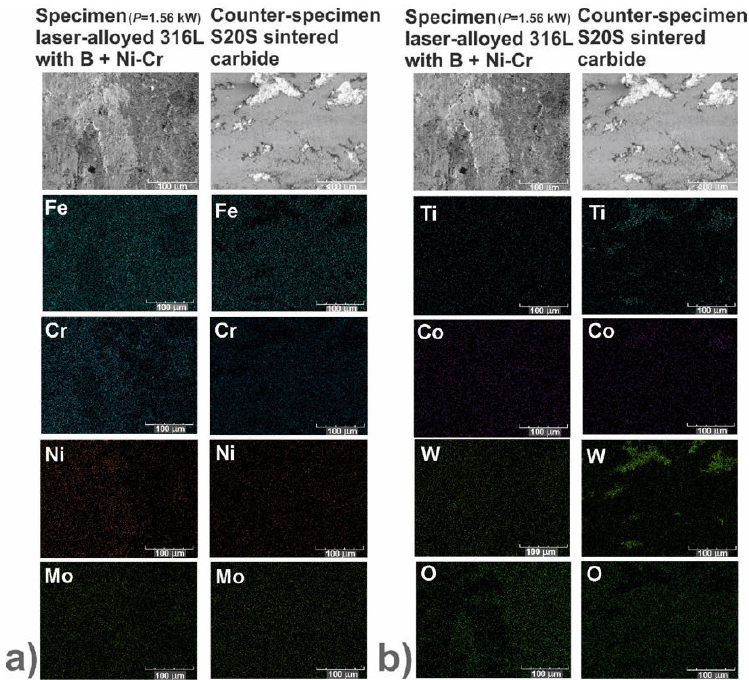
Figure 14. Worn surfaces of laser-alloyed specimen with boron, nickel and chromium using a dilution ratio of 0.49 ( P = 1.56 kW) and counter-specimen (S20S sintered carbide). ( a ) EDS patterns of the elements characteristic of the specimen as well as ( b ) the counter-specimen, taking into account oxygen concentration. Two-hour wear test with the change of counter-specimen at every 0.5